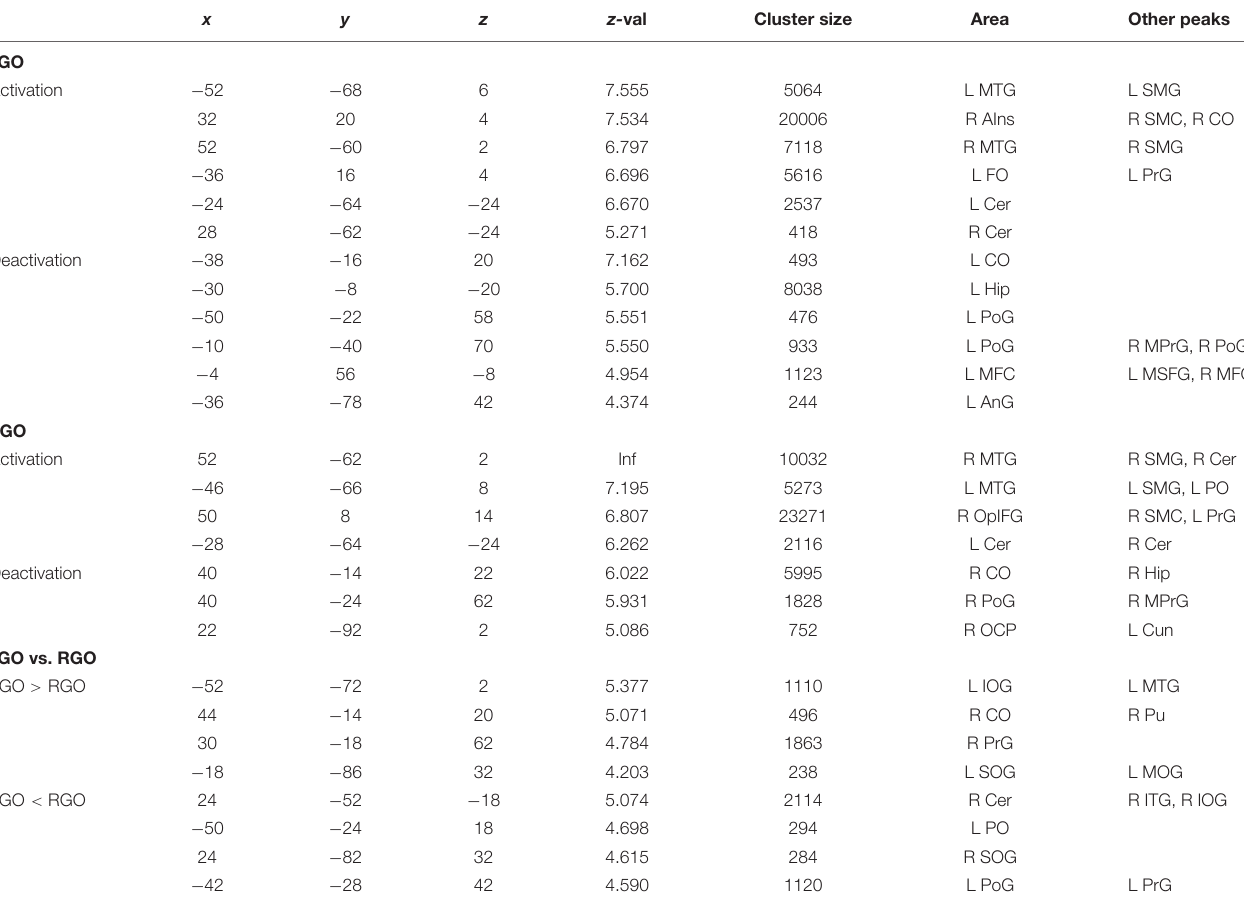
TABLE 2 | Clusters showing significant (FWEc p < 0.05) activation and deactivation during feedback run 1 for the different motor imagery tasks. x y z z- val Cluster size Area Other peaks